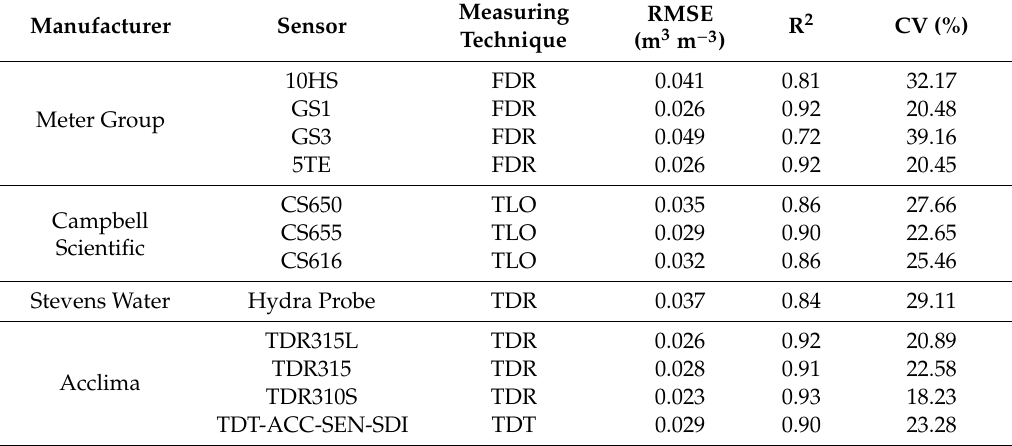
Table 3. Comparative analysis of θ v by sensors and the gravimetric method, where: RMSE = Root mean square error, R 2 = coe ffi cient of determination, and CV = coe ffi cient of variation for each sensor evaluated. The RMSE, R 2 , and CV for each sensor were computed across the three replications by soil series, soil depths, and amount of water added per sample ( n =